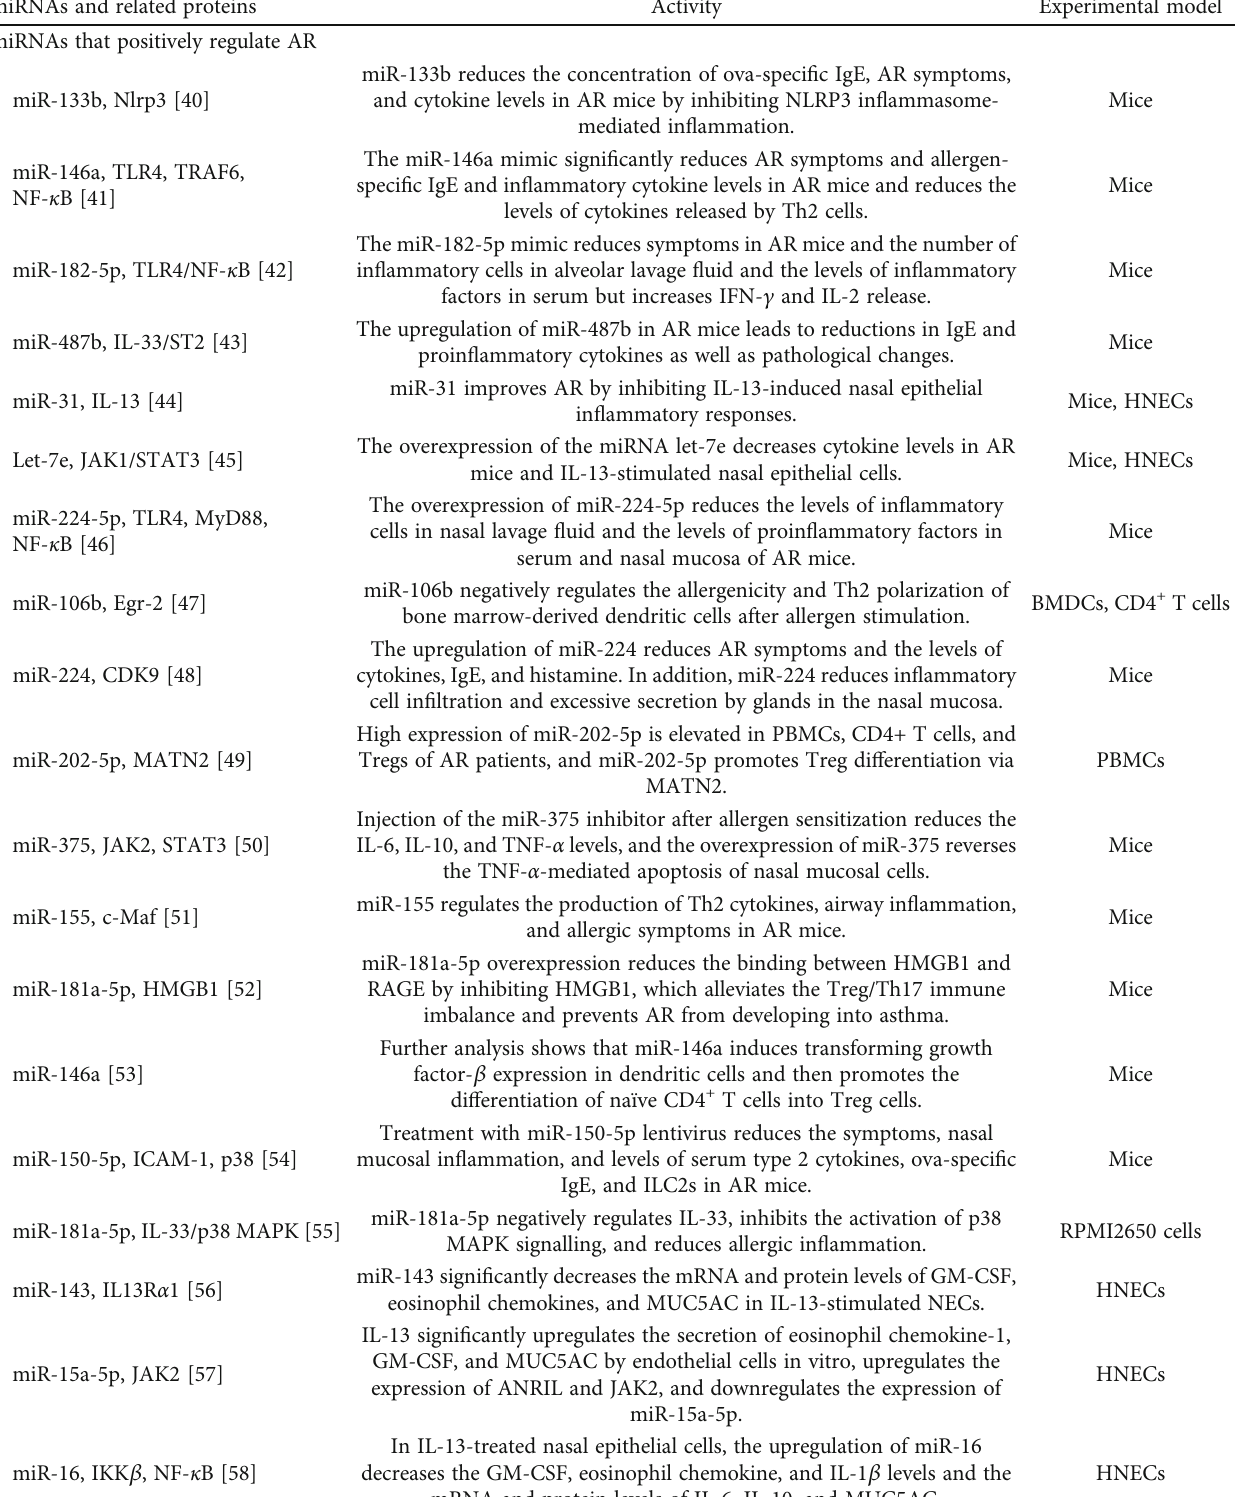
Table 1: miRNAs that regulate allergic rhinitis. HNECs: human nasal epithelial cells, BMDCs: bone marrow-derived dendritic cells, PBMCs: peripheral blood mononuclear